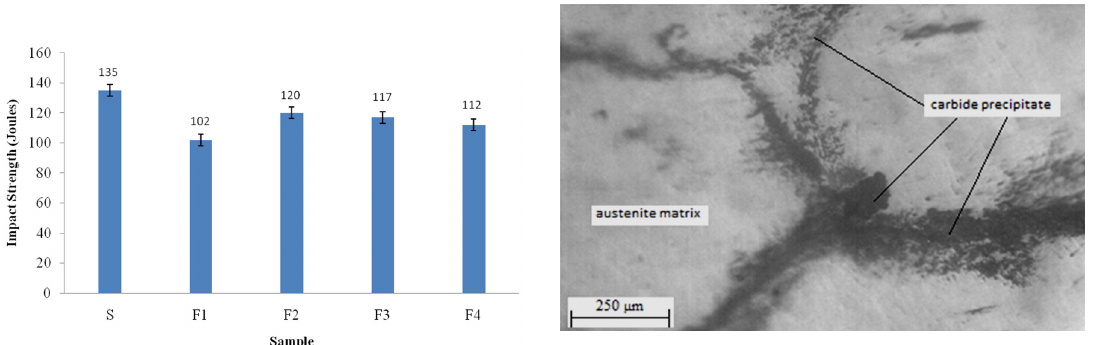
Figure 5. Hardness Value vs Depth for S and F4.